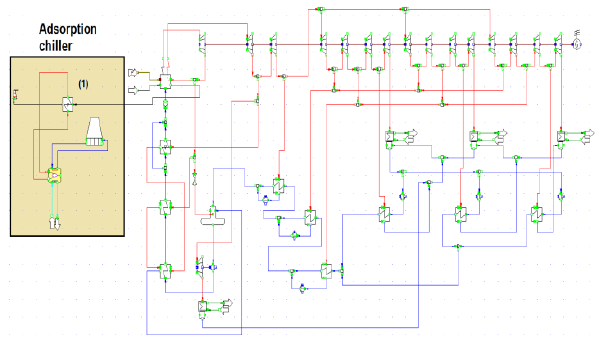
Fig. 3. Power plant integrated with adsorption chiller. Table 3. Summary of the most important